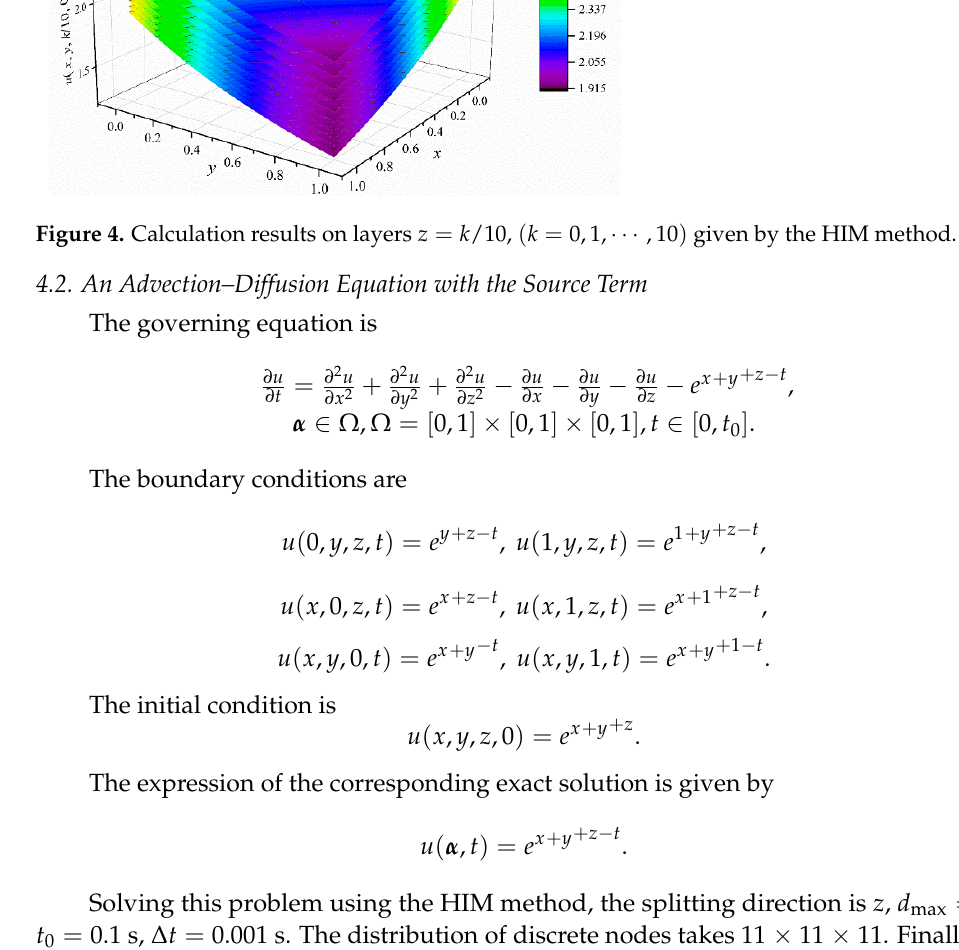
Figure 3. Calculation results along z -axis when